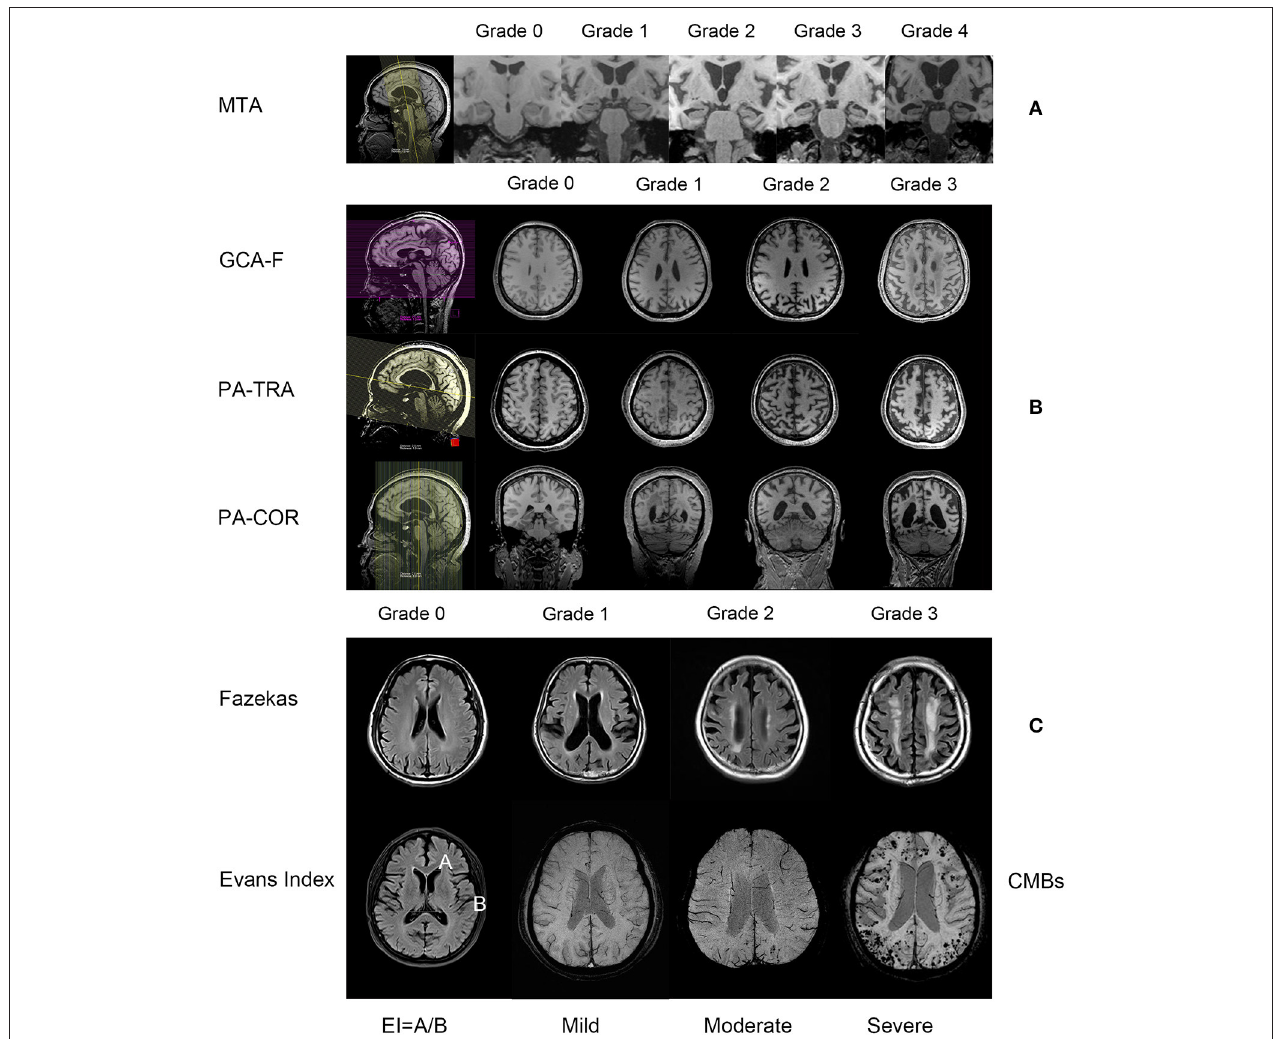
FIGURE 2 | The reconstruction mode and the description of the degree of the MRI visual rating scales (all images are from subjects in this study). (A) contains the MTA visual rating scale, from left to right are the positioning phase, grade 0–4 (3D T1-weighted images, oblique coronal); (B) contains the GCA-F, PA visual rating scale, from left to right are the positioning phase, grade 0–3 (GCA-F is the transverse section of T1-weighted images, PA is the transverse section and coronal section of T1-weighted images); (C) contains the Fazekas visual rating scale, from left to right are grade 0–3 (T2-weighted fluid-attenuated inversion-recovery sequence), the Evans Index, the value is the ratio between the maximal diameter of the anterior horns of the lateral ventricles-A and the greatest internal diameter of the skull-B, and CMBs, according to the number of microbleeds, from left to right are mild, moderate and severe (the figure shows the susceptibility-weighted imaging sequence, the 3D T1-weighted gradient-echo sequence is not shown). MTA, medial temporal lobe atrophy; GCA-F, global cortical atrophy-frontal subscale; PA, posterior atrophy; CMBS, cerebral